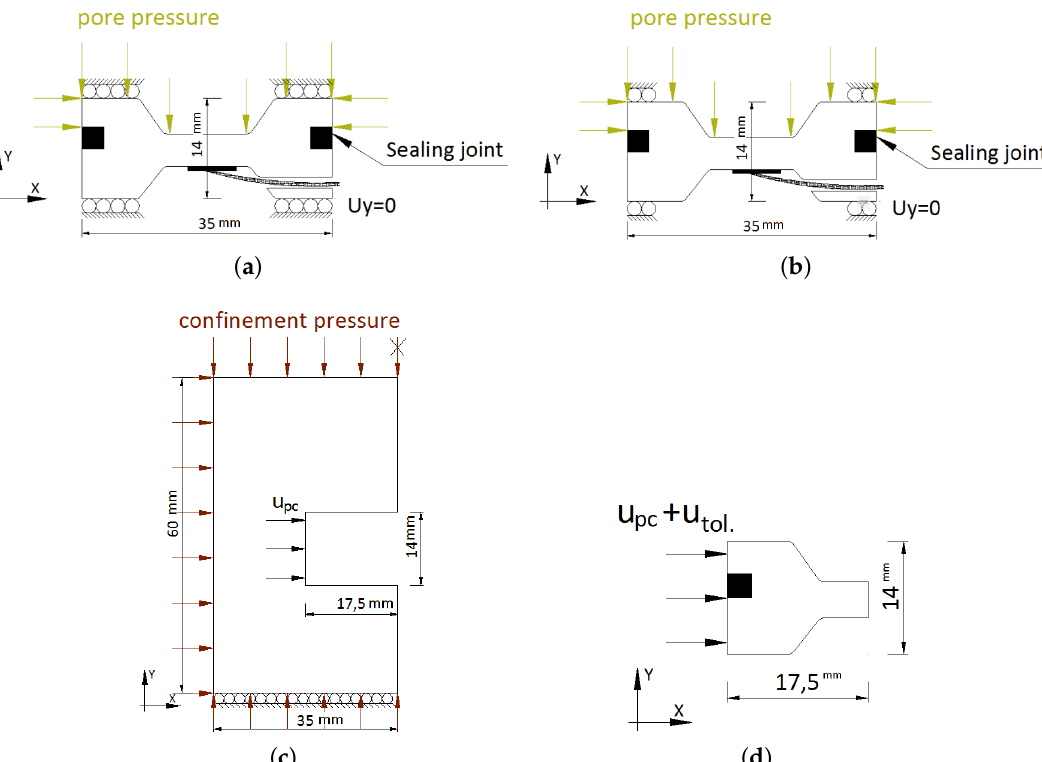
Figure 5. Loading and boundary condition used to simulate the behavior of the pressure sensor: ( a , b ) sensor with all nodes or half nodes fixed; ( c ) water collecting cap inner surface displacement due to the confinement pressure; and ( d ) mechanical effect on the sensor transmitted from the water collecting cap lateral surface due to confining pressure.